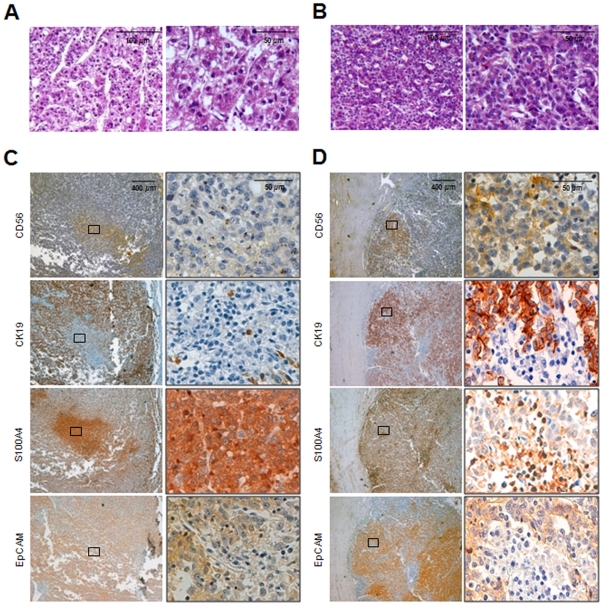
Immunohistochemistry of primary HCC tissue.The staining was chosen on the basis of the characteristic markers of the three cell populations detected in culture: CD56, CK19, S100A4 and EpCAM. A and B) H&E staining showing cell morphology heterogeneity in different tumour areas. C) Left panels: serial tissue sections showing areas with the phenotype resembling hcc-1 (CD56−/CK19+/S100A4−/EpCAM+) and hcc-2 (CD56−/CK19−/S100A4+/EpCAM+/−); right panels: higher magnifications of the areas indicated by the black rectangles. D) Left panels: serial tissue sections showing an area resembling the phenotype of hcc-3 (CD56+/CK19+/S100A4−/EpCAM+); right panels: higher magnifications of the areas indicated by the black rectangles.